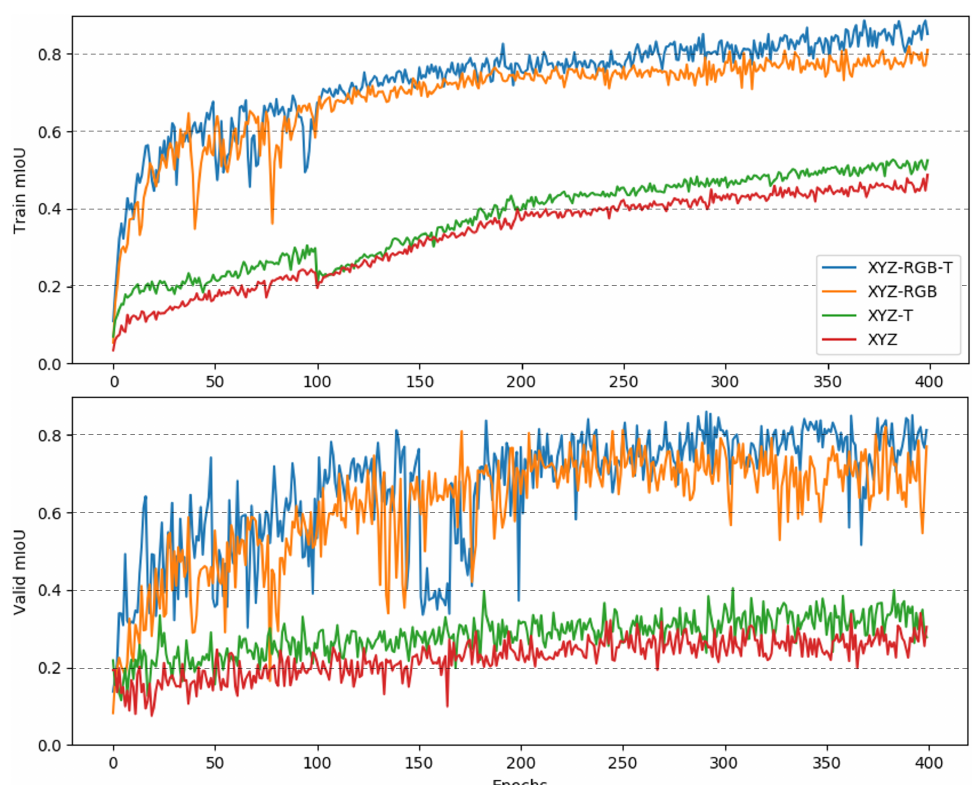
Figure 8. The convergence curves in training phase of RandLA-Net, in which RandLA-Net was trained for 400 epochs on data XYZ, XYZ-T, XYZ-RGB, and XYZ-RGB-T. Upper—the training curve; bottom—the validation